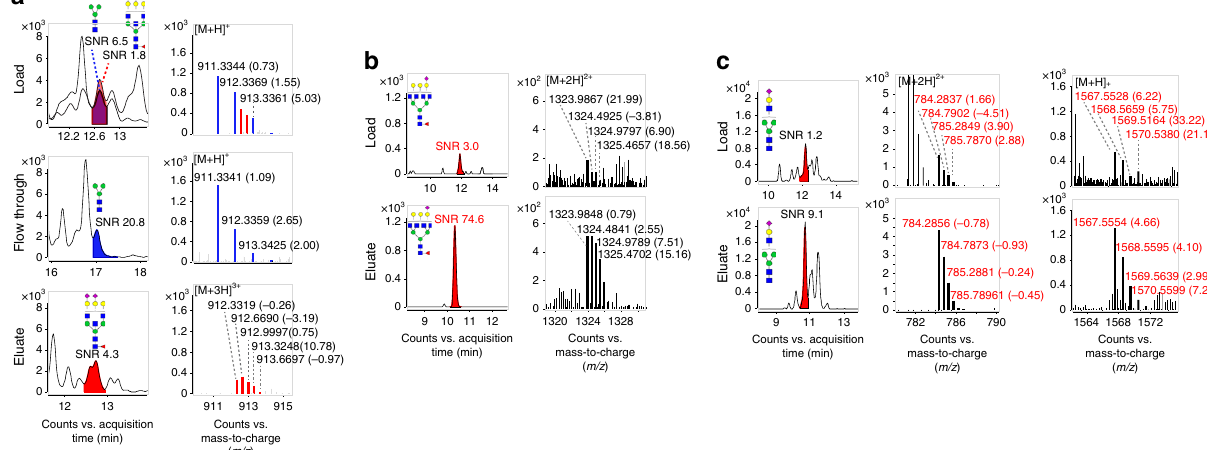
Fig. 2 The greatly improved detection of acidic N-glycans after enrichment on the TiO 2 -PGC chip. In a , the [M+3H] 3+ ions of an acidic N-glycan were overlapped with the isotopic ions of co-eluted neutral N-glycans and could not be assigned accurately. Using the TiO 2 -PGC chip, the acidic N-glycans were enriched ef fi ciently and detected with an enhanced S/N and improved mass accuracy because of the removal of interference from neutral N-glycans. In b , the signal intensity as well as the S/N of acidic N-glycans were signi fi cantly enhanced after on-chip enrichment because of the reduced ion-suppression derived from neutral N-glycans/matrix. In c , with the removal of noise derived from neutral N-glycans/matrix, the acidic N-glycan mass accuracy was signi fi cantly enhanced, thus providing reliable evidence for the identi fi cation of acidic N-glycans. The number in the bracket beside each mass value indicates the mass error